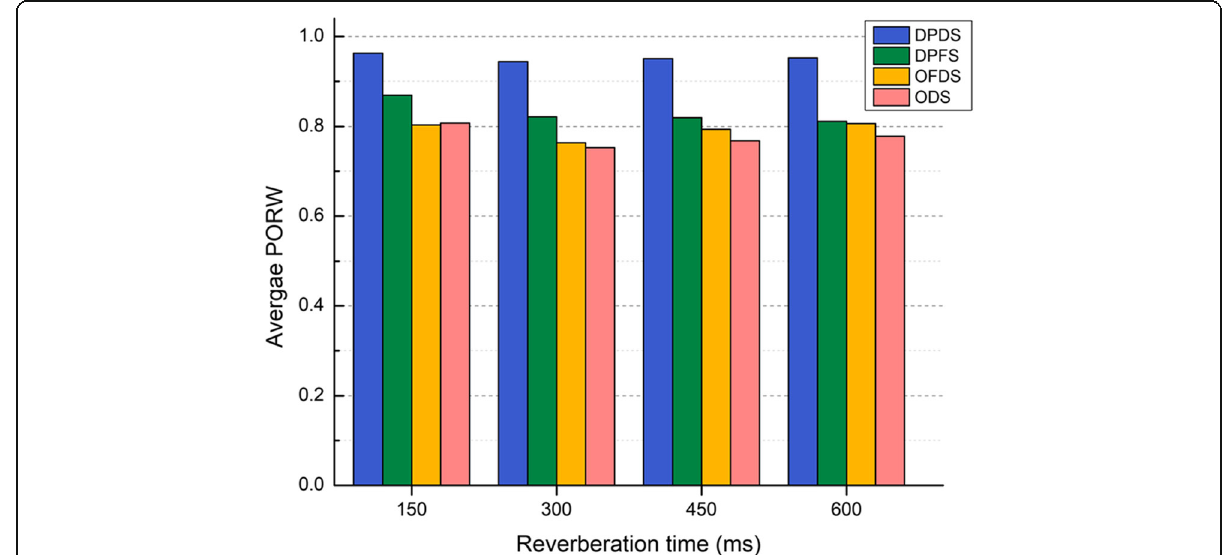
Fig. 3 PORW of four kinds of points with different reverberation